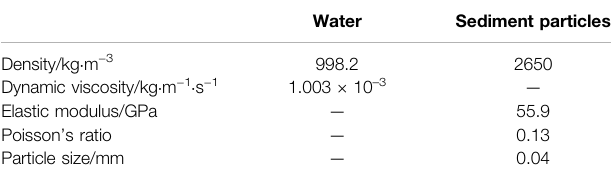
TABLE 1 | Material properties.